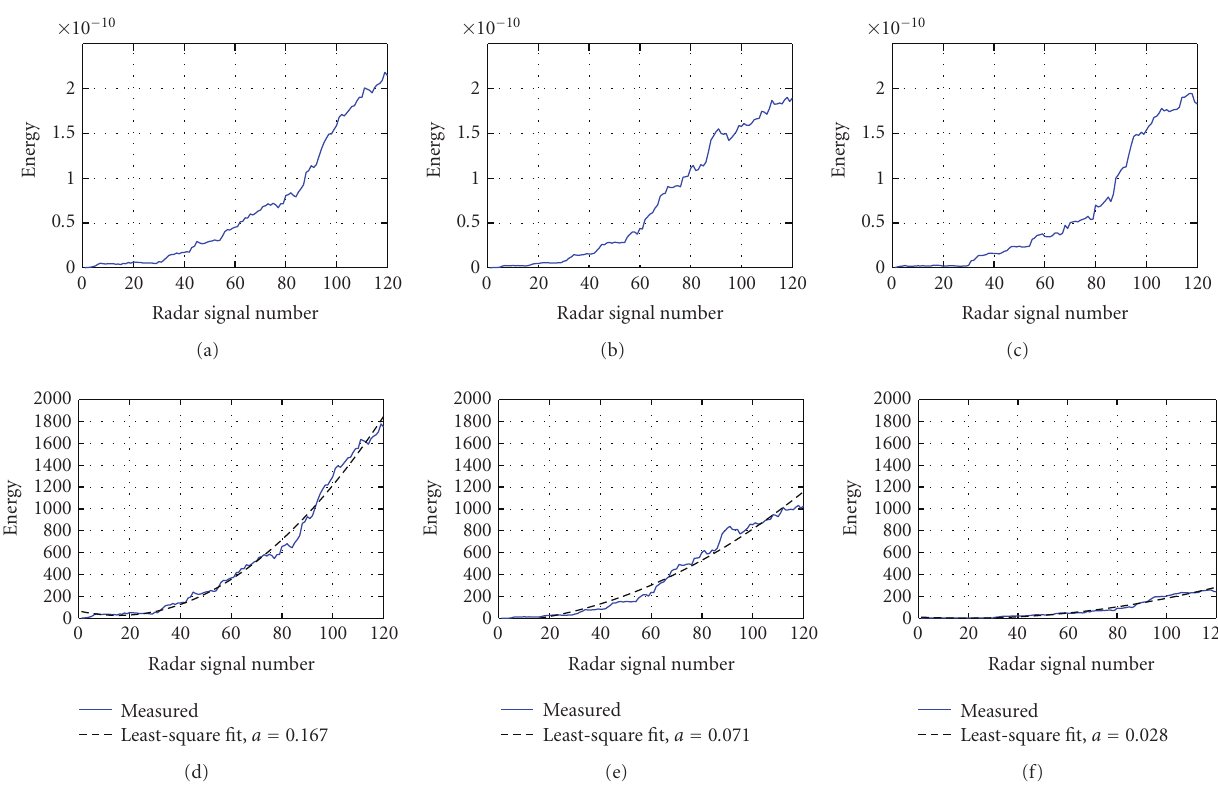
Figure 5: Curves of energy collection at focal points P T , P 1 , and P 2 (see Figure 6(a)): (a) curve for P T as in standard DAS, (b) curve for P 1 as in standard DAS, (c) curve for P 2 in standard DAS, (d) curve for P T as in improved DAS together with the fitted polynomial, (e) curve for P 1 in the improved DAS together with the fitted polynomial, (f) curve for P 2 in the improved DAS together with thefitted polynomial.